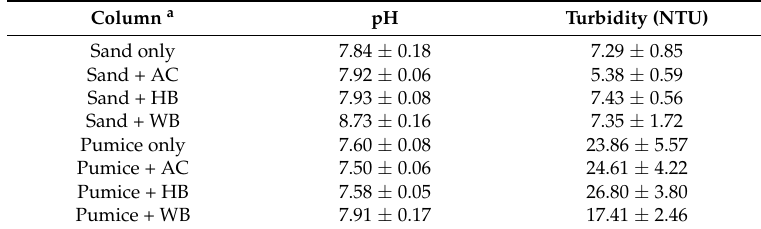
Table 3. Average pH and turbidity (mean ± standard error) in column effluents over the entire leaching events.